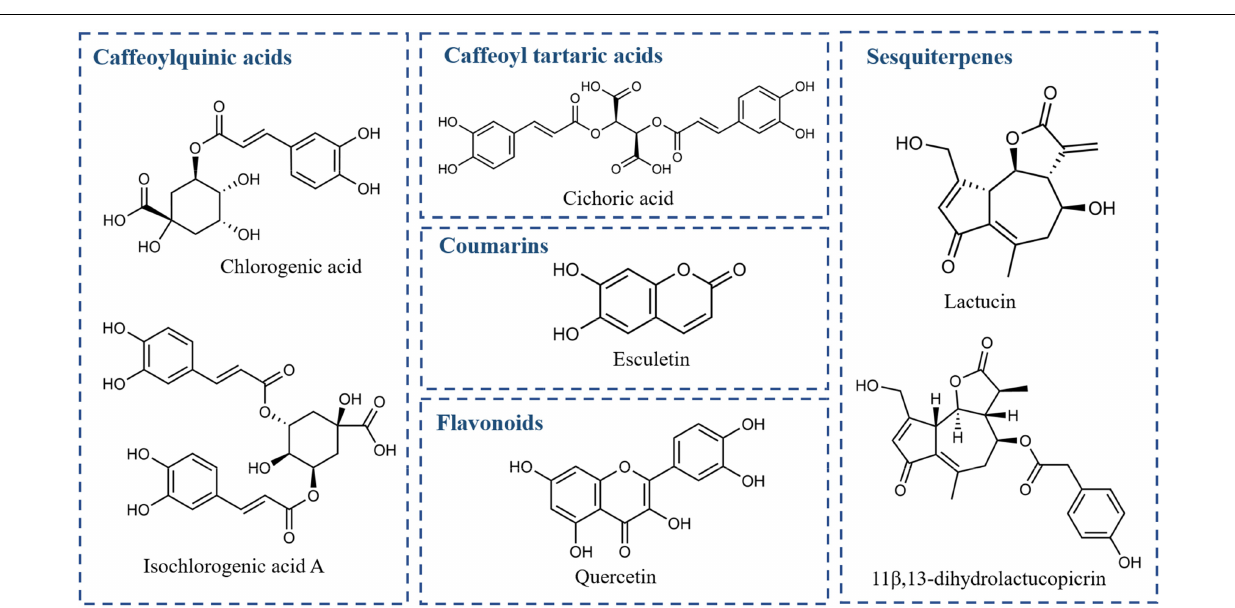
FIGURE 7 | Structures of seven potential Q markers in